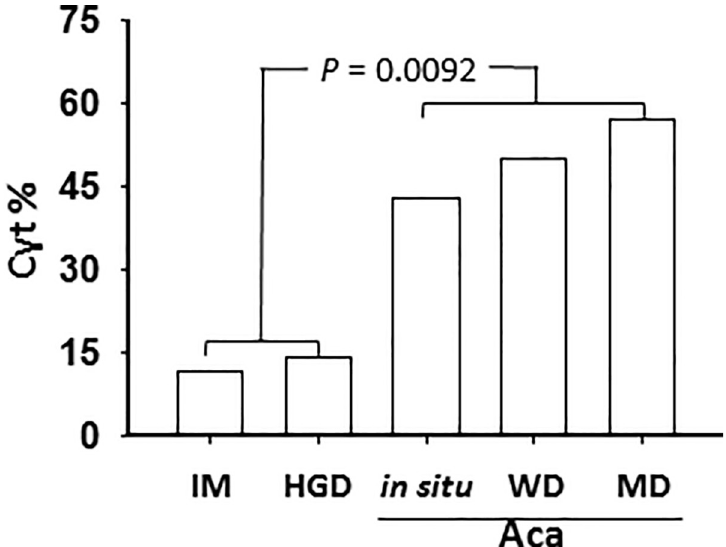
Fig 4. Maspin Cyt subtype correlates with ECA/GEJ Aca progression. Analysis of the percentage of Cyt subtype in each GEJ pathological grade. A statistically significant difference was found between the combined IM and HGD subtypes and the ECA/GEJ Aca subtypes (Fisher test: p = 0.0092).